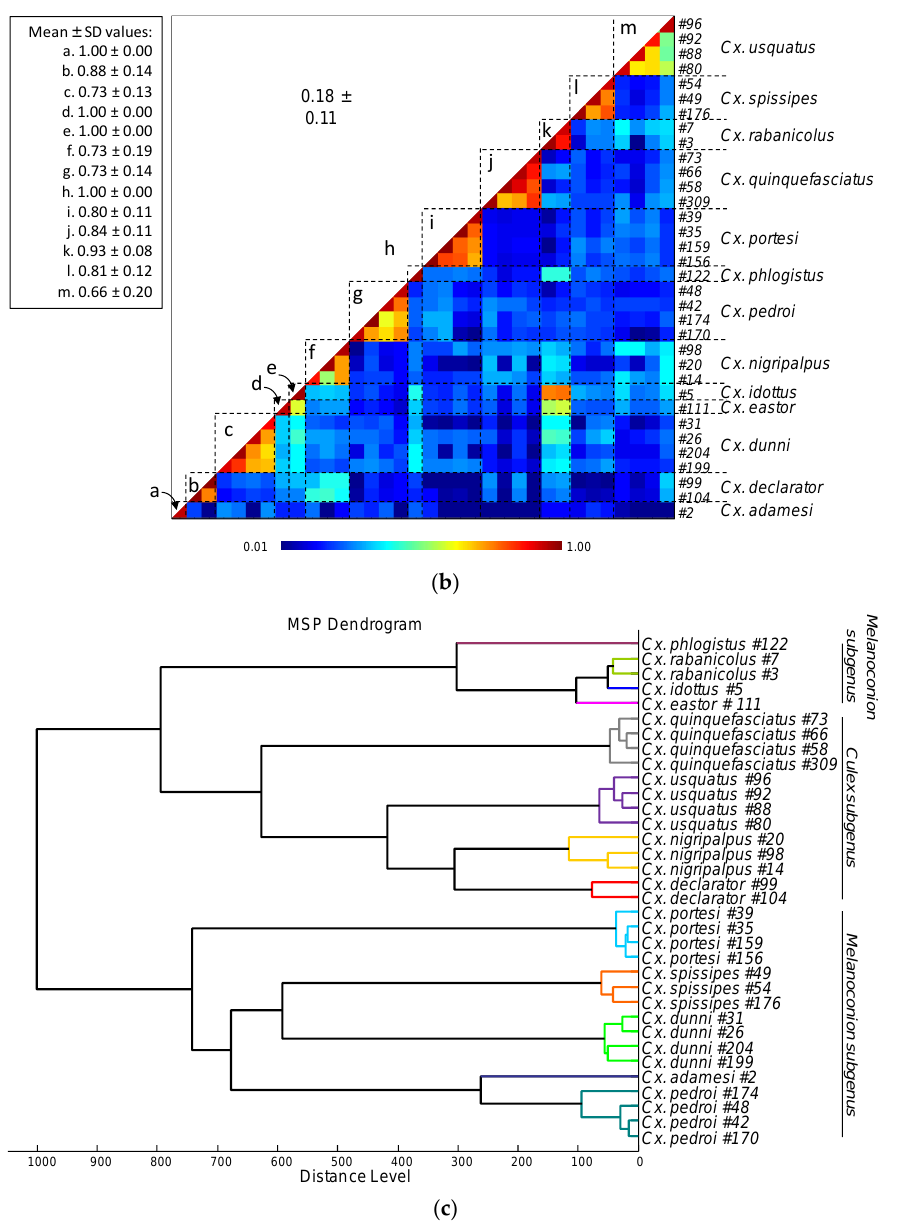
Figure 2. Comparison of MALDI-TOF MS spectra from thoraxes of Culex mosquitoes. ( a ) Representative thoraxes MS spectra of Culex species. The name of each species was indicated on the right corner of each spectrum. ( b ) Composite Correlation Index (CCI) matrix value representing the levels of thoraxes MS spectra reproducibility among Culex specimens of the same species and between species. The 34 specimens from the 13 Culex species, which were selected as reference MS spectra introduced in the MS DB, are shown. The levels of MS spectra reproducibility are indicated in red and blue, revealing relatedness and incongruence between spectra, respectively. The values correspond to the mean coefficient correlation and respective standard deviations obtained for paired condition comparisons. CCI was calculated with MALDI-Biotyper v.3.0 software. ( c ) MSP dendrogram of MALDI-TOF MS spectra from thoraxes of Culex mosquitoes, from the 34 Culex specimens selected as reference MS spectra. The Culex and Melanoconion subgenera were indicated at the right. The distance units correspond to the relative similarity of MS spectra. The dendrogram was created by MALDI-Biotyper v.3.0 software. The same color code was used for specimens of the same Culex species between panels ( a , c ). a.u., arbitrary units; Cx. , Culex ; MSP, Main Spectrum Profile; m/z, mass-to-charge ratio; SD, standard